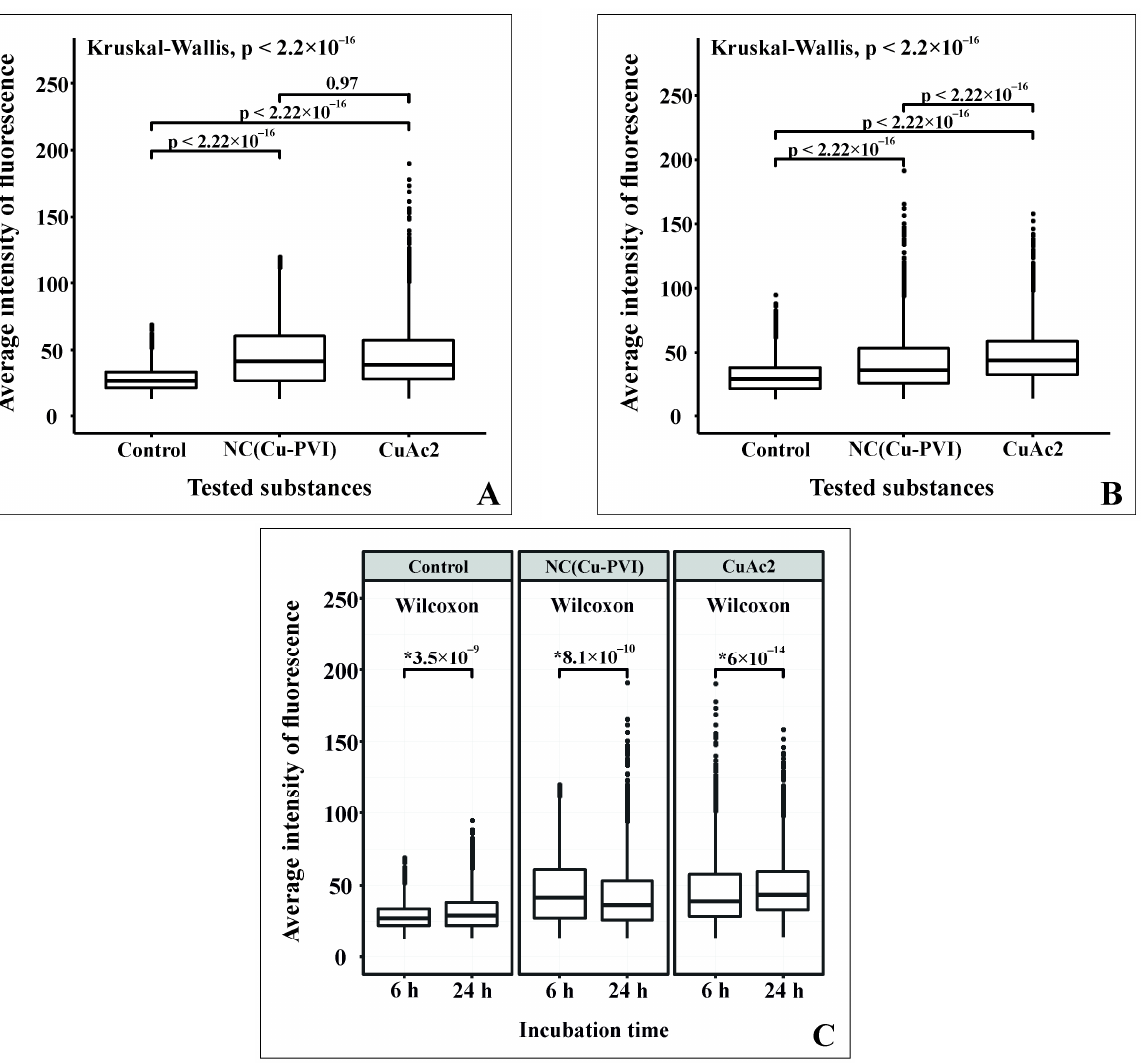
Figure 10. Changes in the glutathione synthetase fluorescent stain intensity in the hepatocyte culture after 6 h ( A ) and 24 h ( B ) of incubation with the NC(Cu-PVI) or CuAc 2 in comparison with the control group and depending on the duration of incubation ( C ). Medians and first and third quartiles are shown. * Differences are considered significant at p < 0.05.